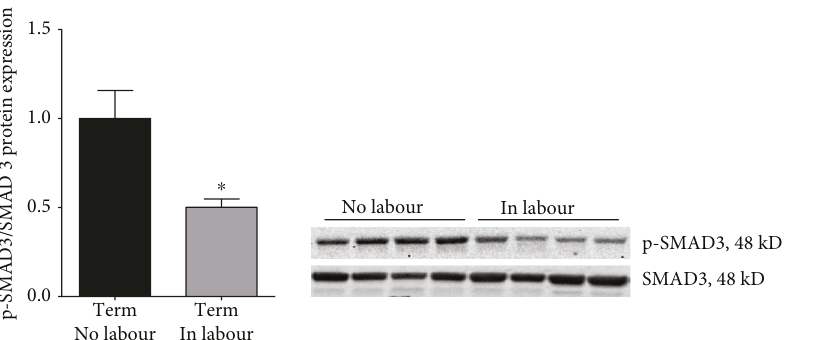
Figure 1: Expression of SMAD3 in the myometrium. Human myometrium was obtained from nonlabouring (term no labour, n = 8 patients) and labouring women at term Caesarean section (term in labour, n = 8 patients). Phosphorylation of SMAD3 at serine 423/425 (p-SMAD3) was analysed by Western blotting. Phosphorylated SMAD3 protein expression was normalised to total SMAD3 protein expression and the fold change was calculated relative to the no labour group. Data is displayed as mean ± SEM. ∗ P ≤ 0 05 vs. term no labour (Mann – Whitney U test). A representative Western blot from 4 patients per group is also